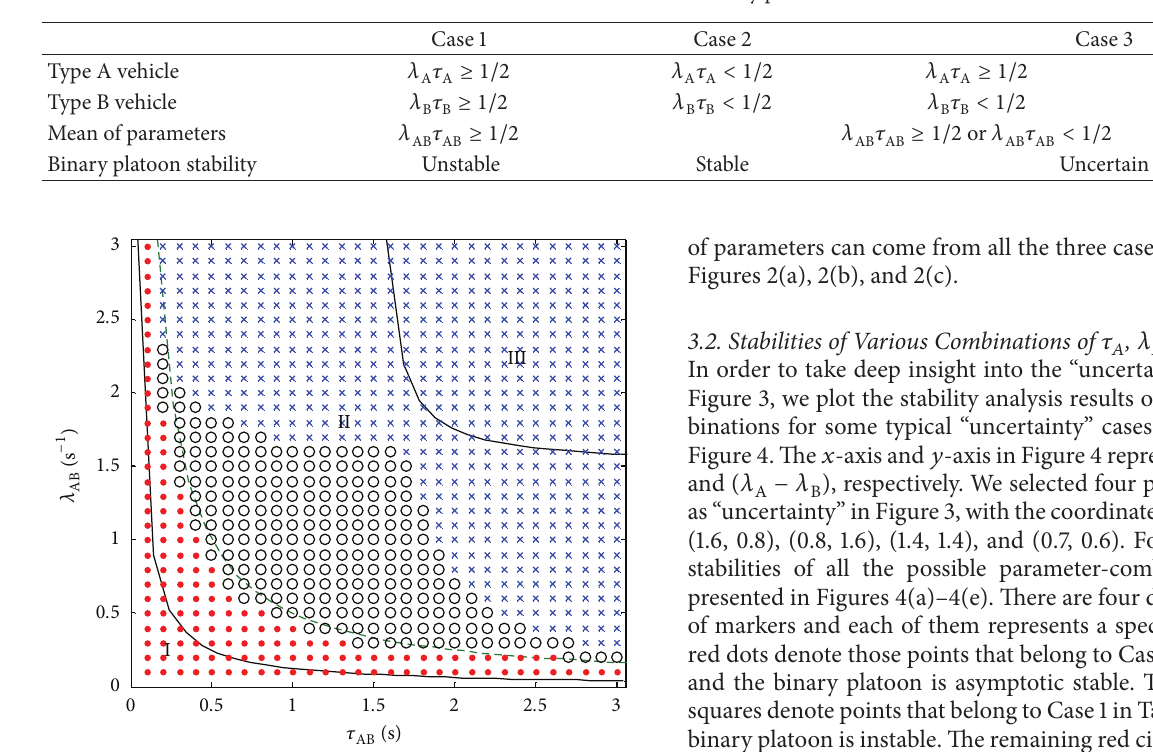
Figure 3: Stability results of binary platoon in 𝜆 AB - 𝜏 AB plot (color